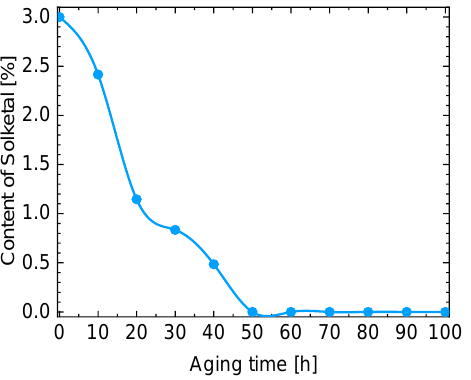
Figure 5 . Development of solketal content of the C18:1 + 3 wt% S blends over time by using GC–MS. Number of measurements ( n = 2).